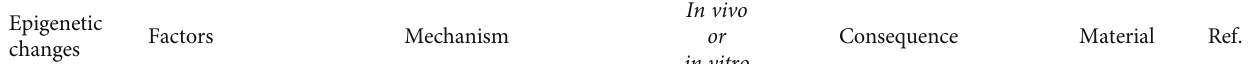
Table 2: Histone modi fi cation in MSC aging and related